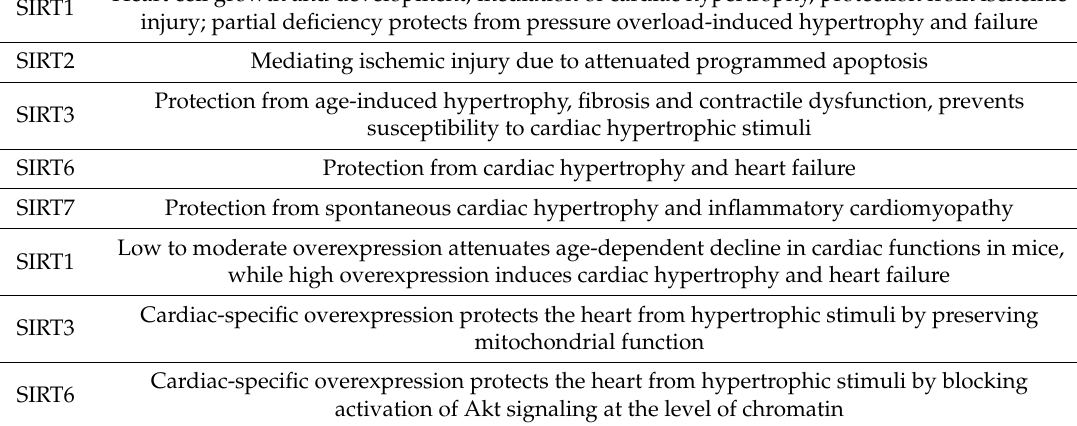
Table 2. The roles of sirtuins in heart failure development acquired from experiments on knock-out and transgenic mice (adapted from Pillai et al., [84]). Heart cell growth and development, mediation of cardiac hypertrophy, protection from ischemic SIRT1 injury; partial deficiency protects from pressure overload-induced hypertrophy and failure